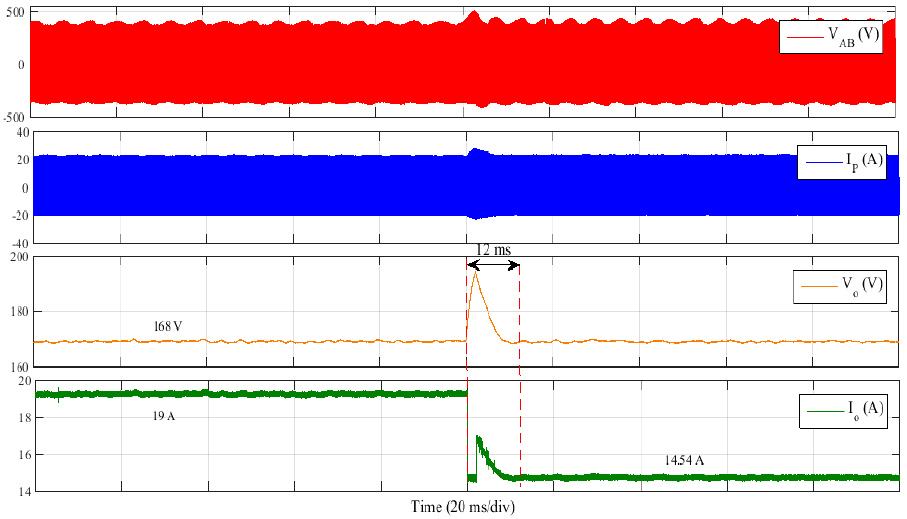
Figure 10. Experimental results for step change in load.